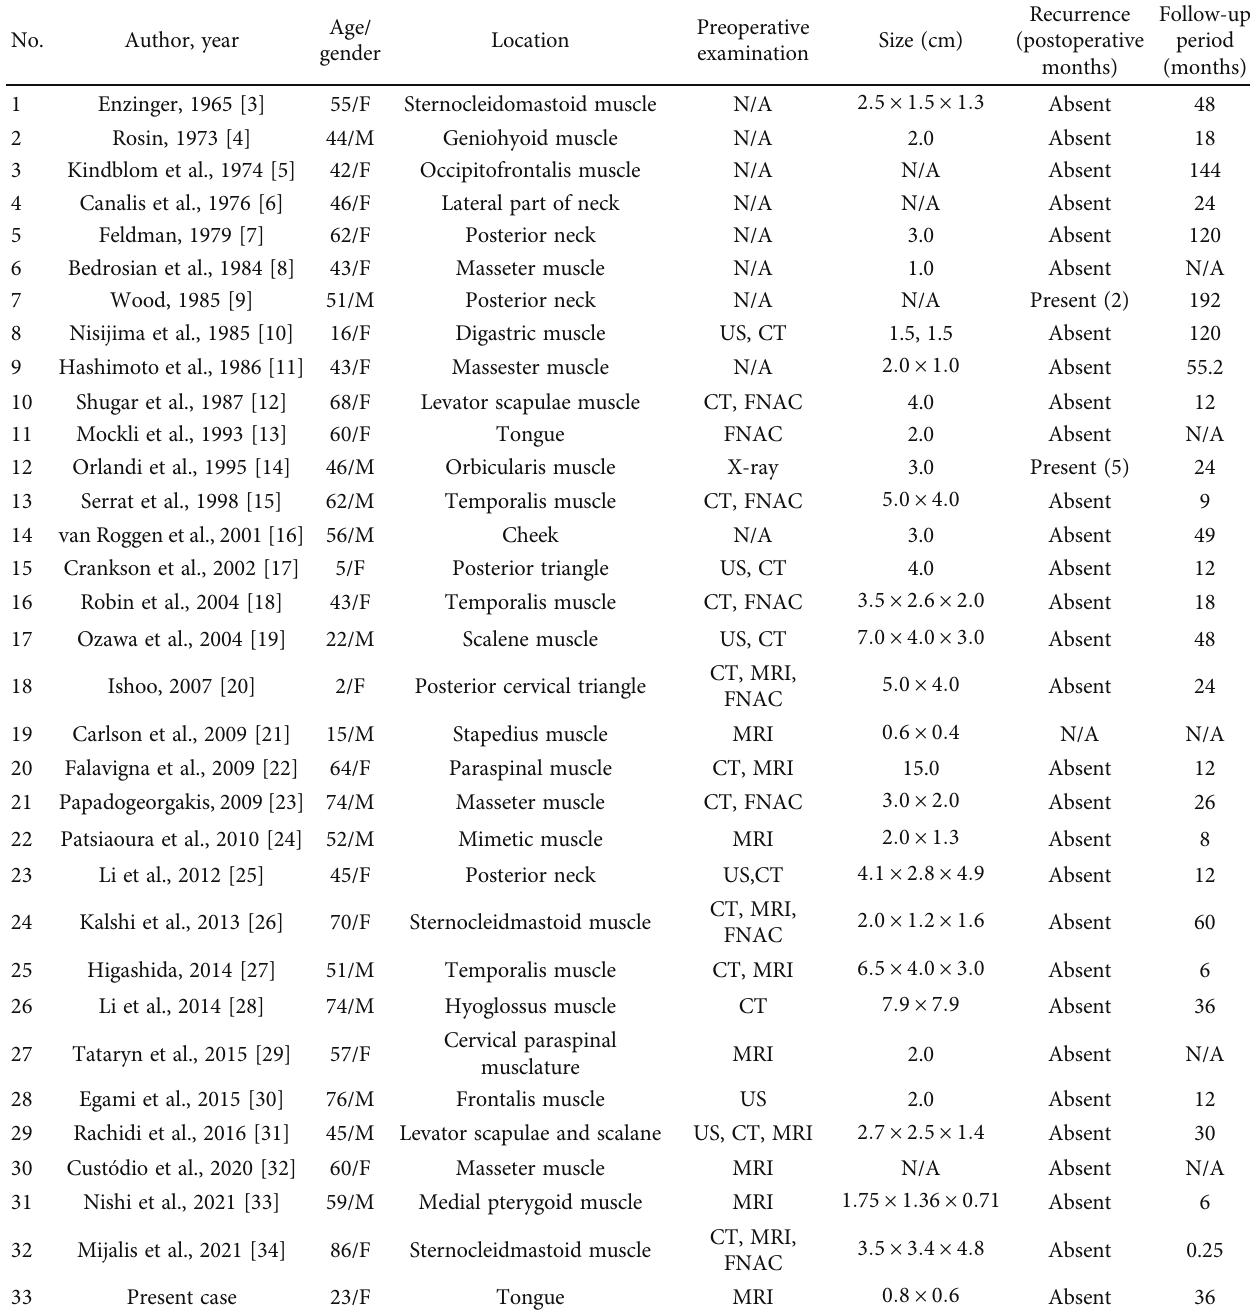
Table 1: Reported cases of intramuscular Myxoma in the head and